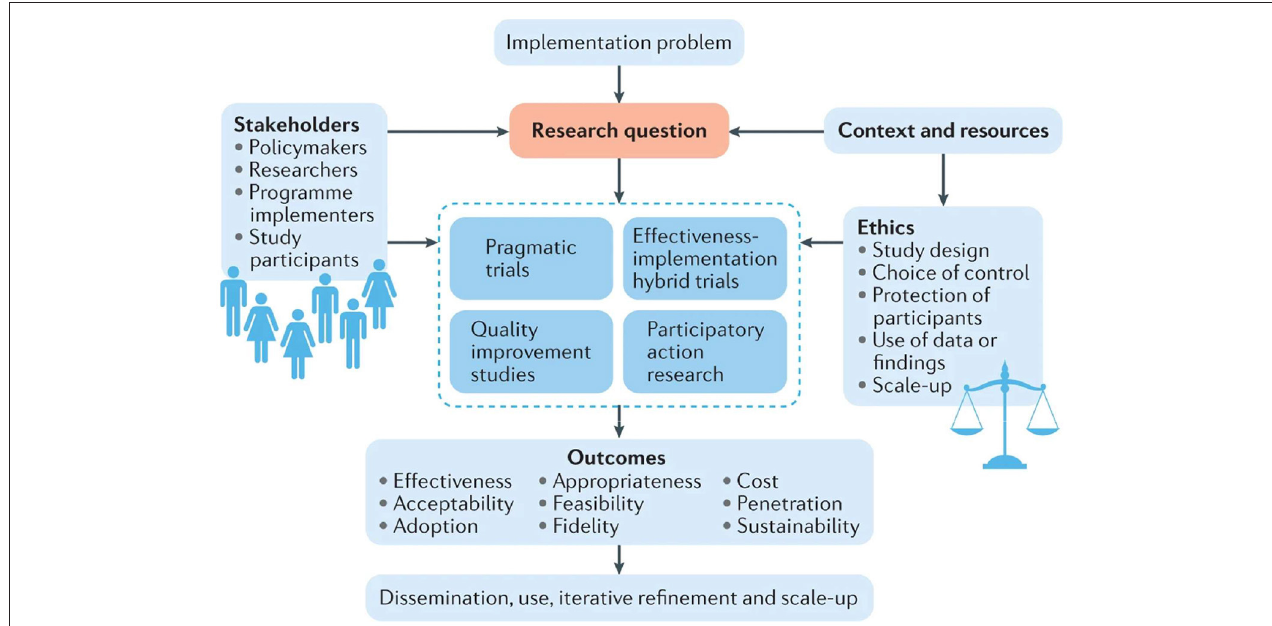
FIGURE 1 | Implementation research plan for policy